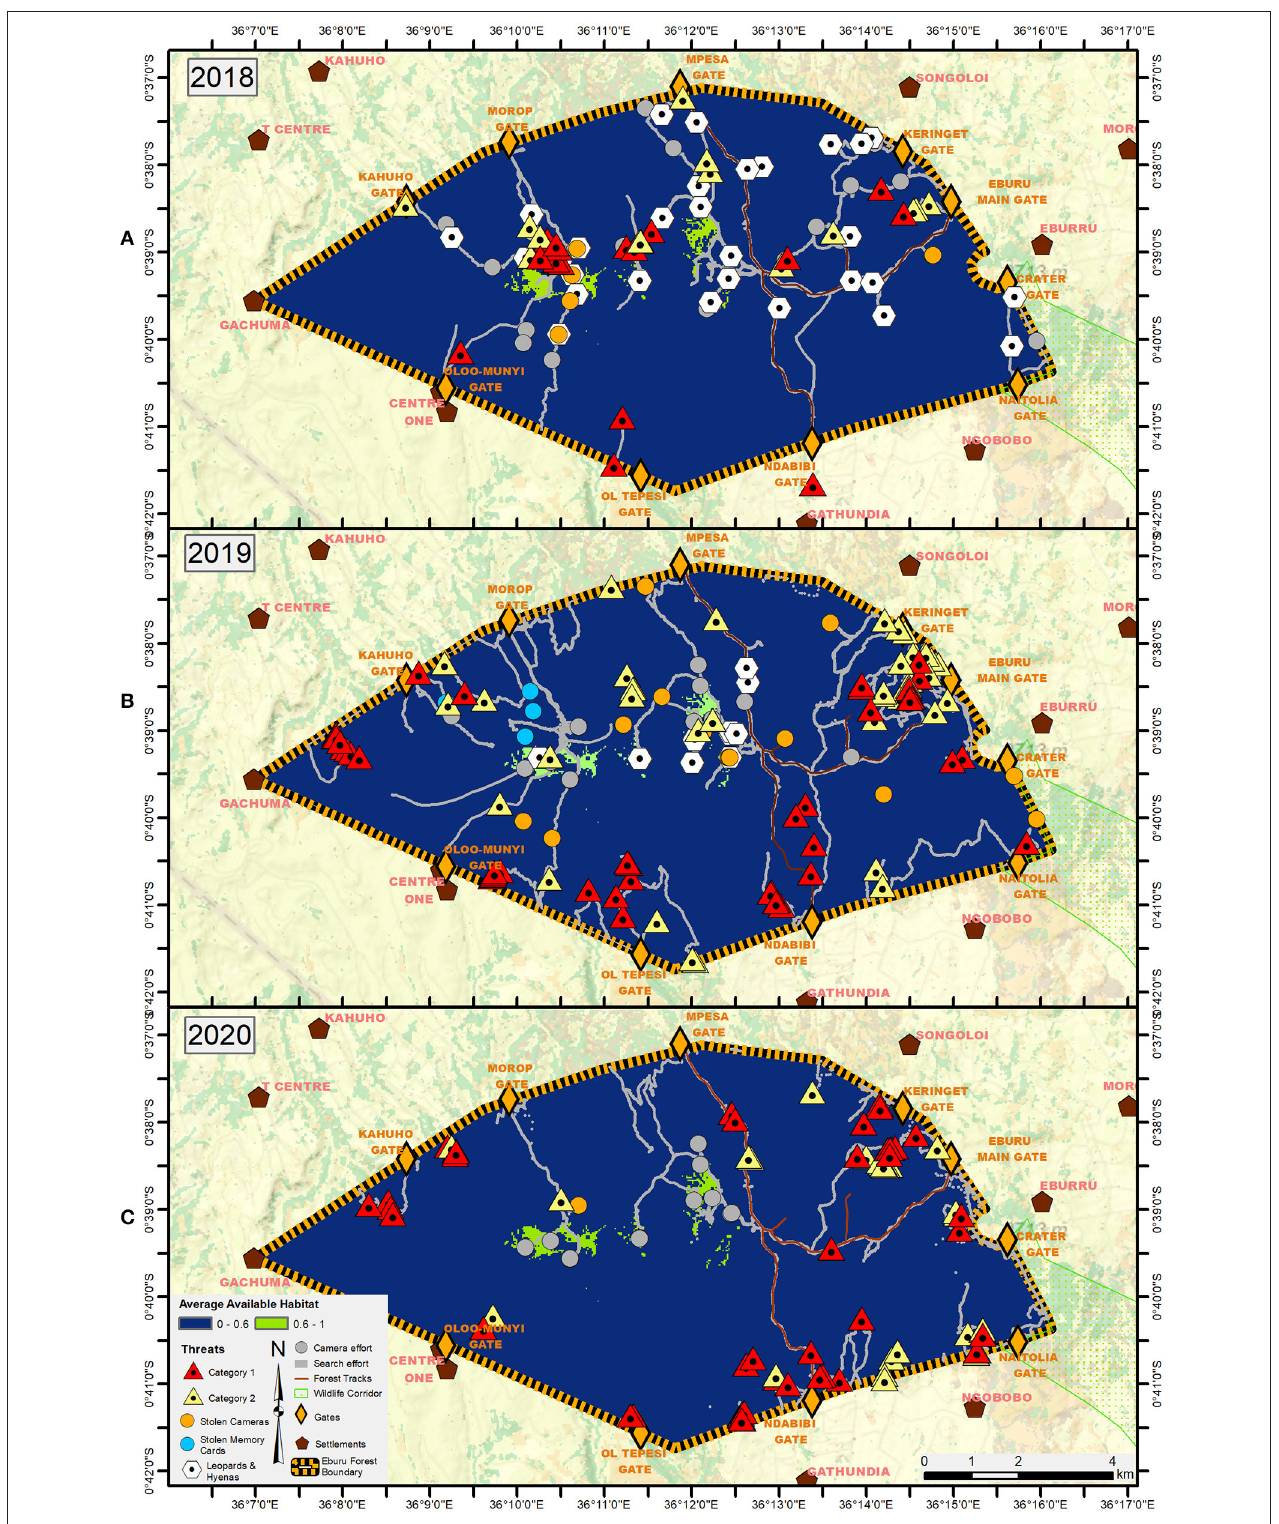
FIGURE 3 | Threats detected in Eburu forest in (A) 2018, (B) 2019, and (C) 2020, including direct threats to bongo (Threat Category 1: evidence of poaching such as leg traps and neck snares), threats to bongo habitat (Threat Category 2: evidence of charcoal production, logging, illegal camps, firewood collection, donkey tracks, and marijuana fields), interference with camera traps, and signs of potential predators (leopards, hyenas). In 2020, the impact of COVID-19 on field operations demanded focus on data for mountain bongo and human threats, so we do not have reliable predator data for 2020.